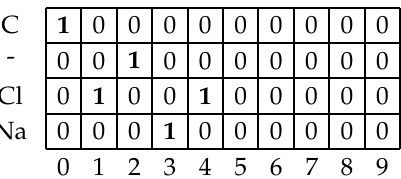
Figure 2. An example of the prepared one-hot matrix containing an example SMILES molecule “CCl-NaCl”. Ones bolded for